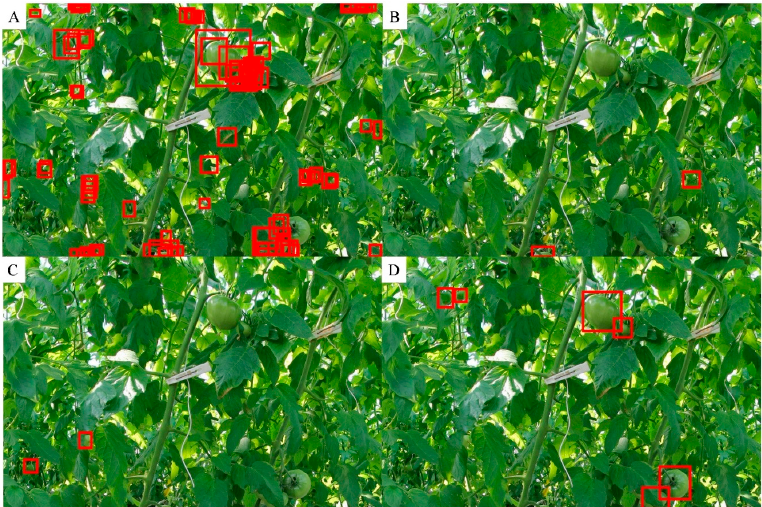
Figure 4. Distribution of true positives and false positives with scores by applying the tomato detection model on the test dataset. ( A ) Percentage change of true positives and false positives with scores; ( B ) relative frequency change of true positives and false positives.